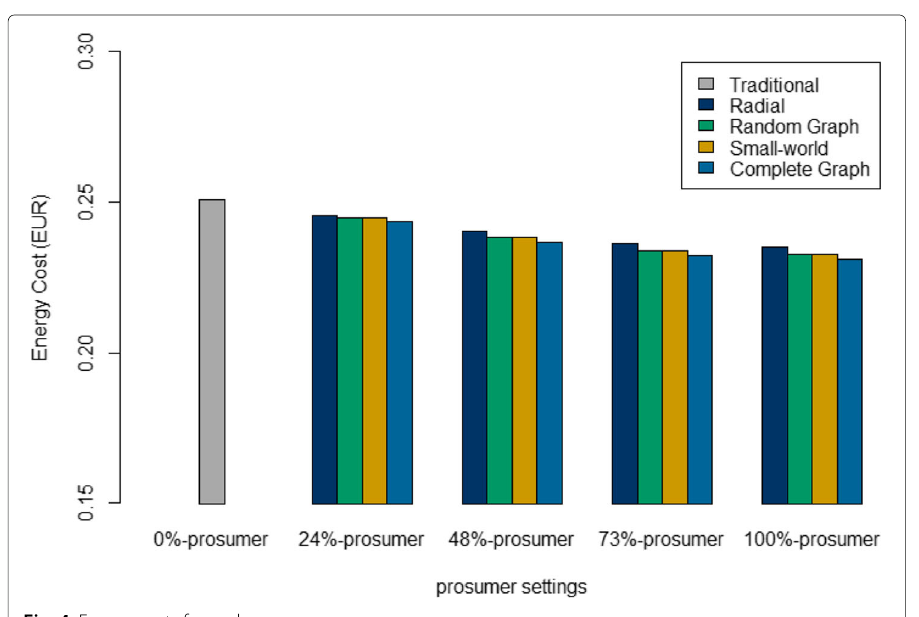
Fig. 4 Energy costs for